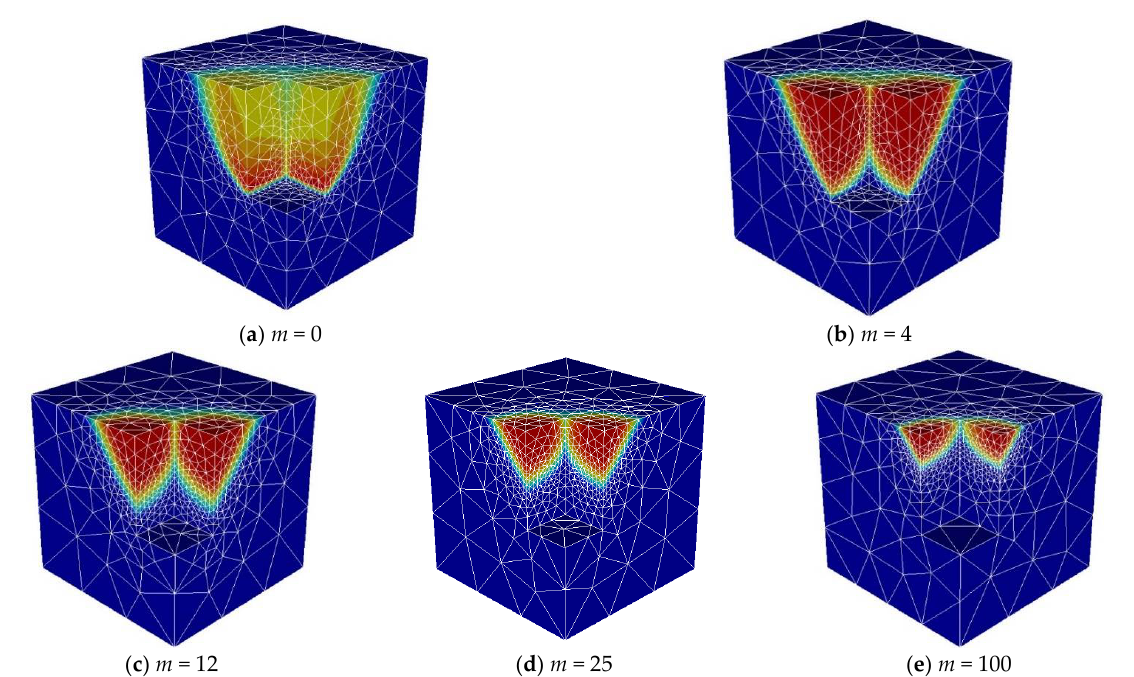
Figure 10. Potential failure mechanisms—effect of m ( r e = 0.7, H/B = 1, and B/L = 1).